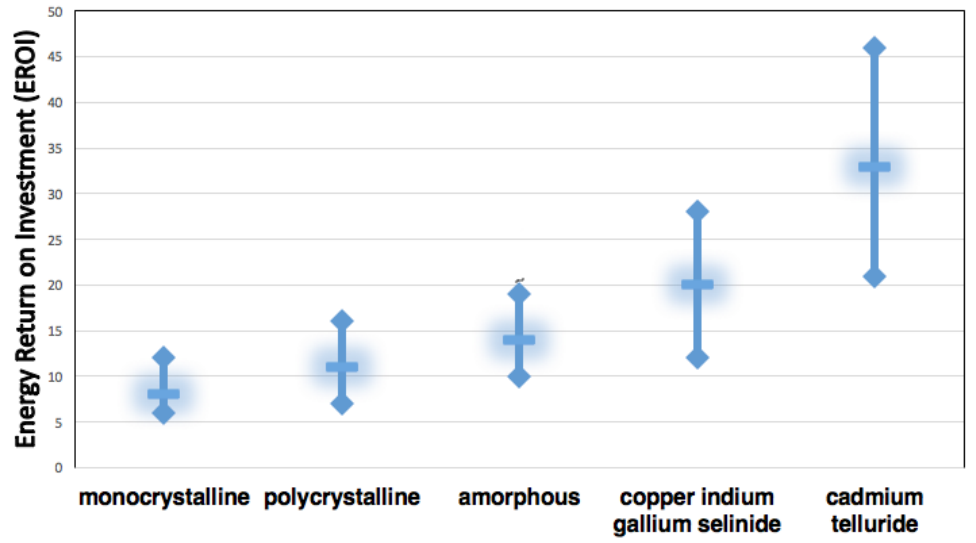
Figure 11. Mean harmonized EROI for photovoltaics with error bars representing one standard deviation for each module type [32].